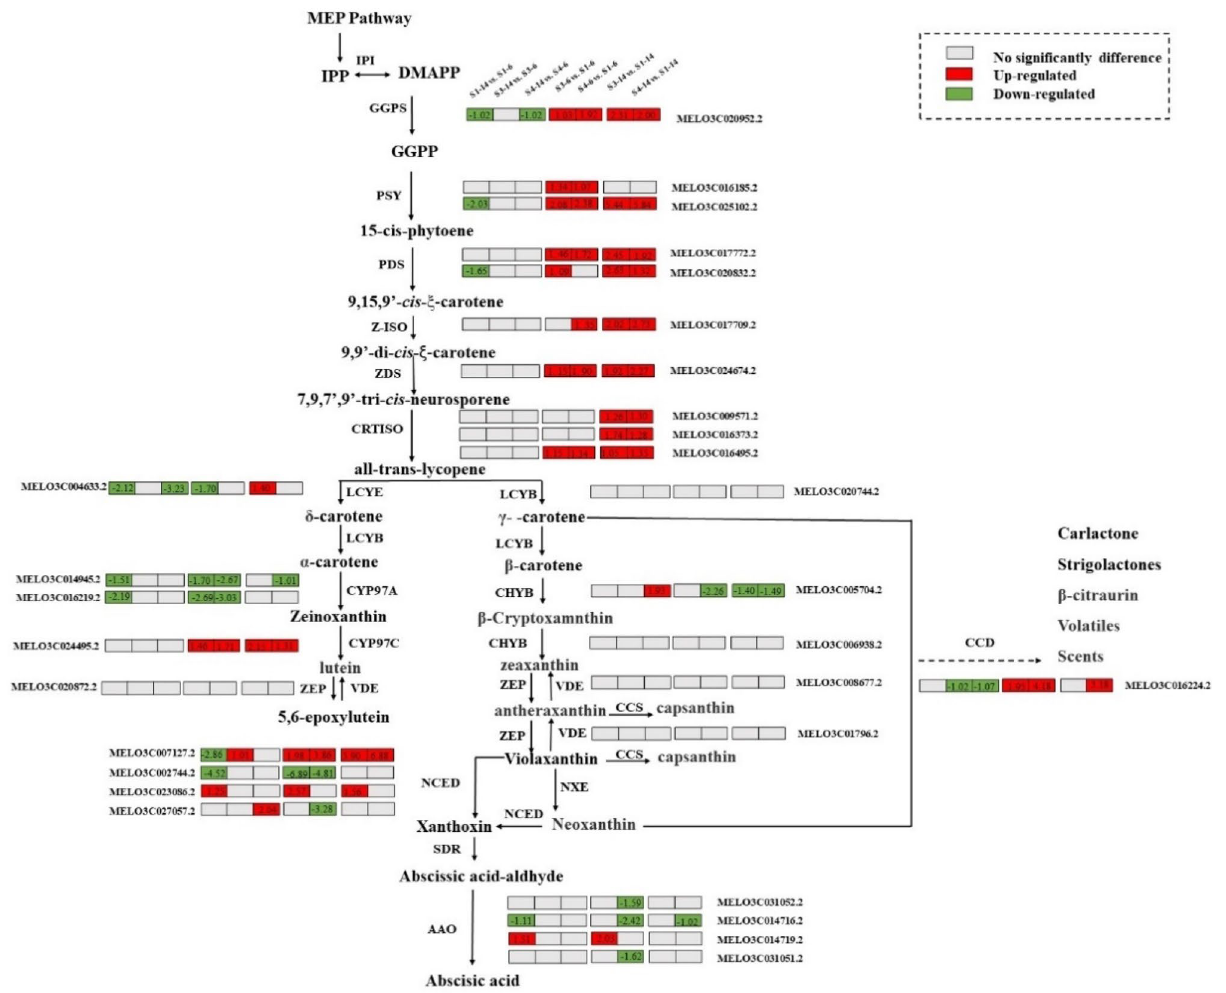
Figure 6. Expression patterns of genes involved in carotenoid metabolism in “1_14” versus “1_6”, “3_14” versus “3_6”, “4_14” versus “4_6”, “3_6” versus “1_6”, “4_6” versus “1_6”, “3_14” versus “1_14”, “4_14” versus “1_14” groups. Gray represents no significant difference in the comparison groups, red represents upregulated expression in the comparison groups, and green represents downregulated expression in the comparison MELO3C016495.2), and ZDS (MELO3C024674.2), and downstream synthesis genes, CCD4 (MELO3C016224.2), NCED2 (MELO3C007127.2), and VDE1 (MELO3C008677.2), were the highest in the “4_14” group, followed